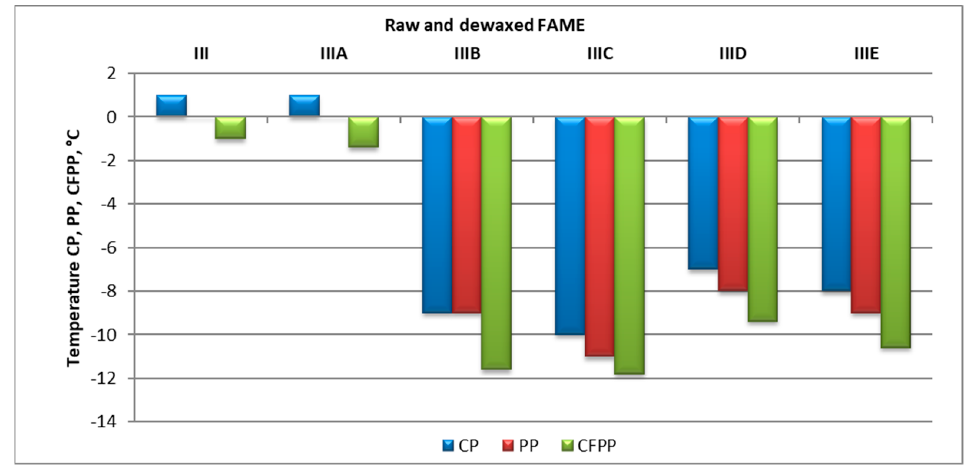
Figure 4. Low-temperature properties of raw FAME III and modified biofuels.